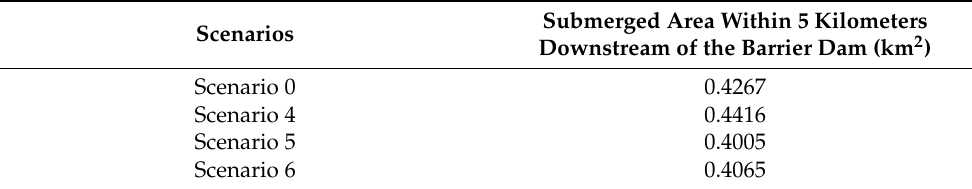
Figure 13. Inundation range of floods under different spillways. Table 8. Submerged area of scenarios 0, 4, 5, and